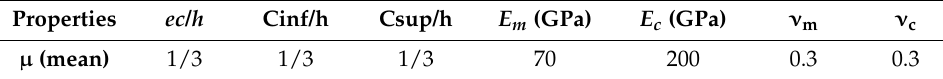
Table 7. Parameters mean values: case 3.2.2—Thinner core.